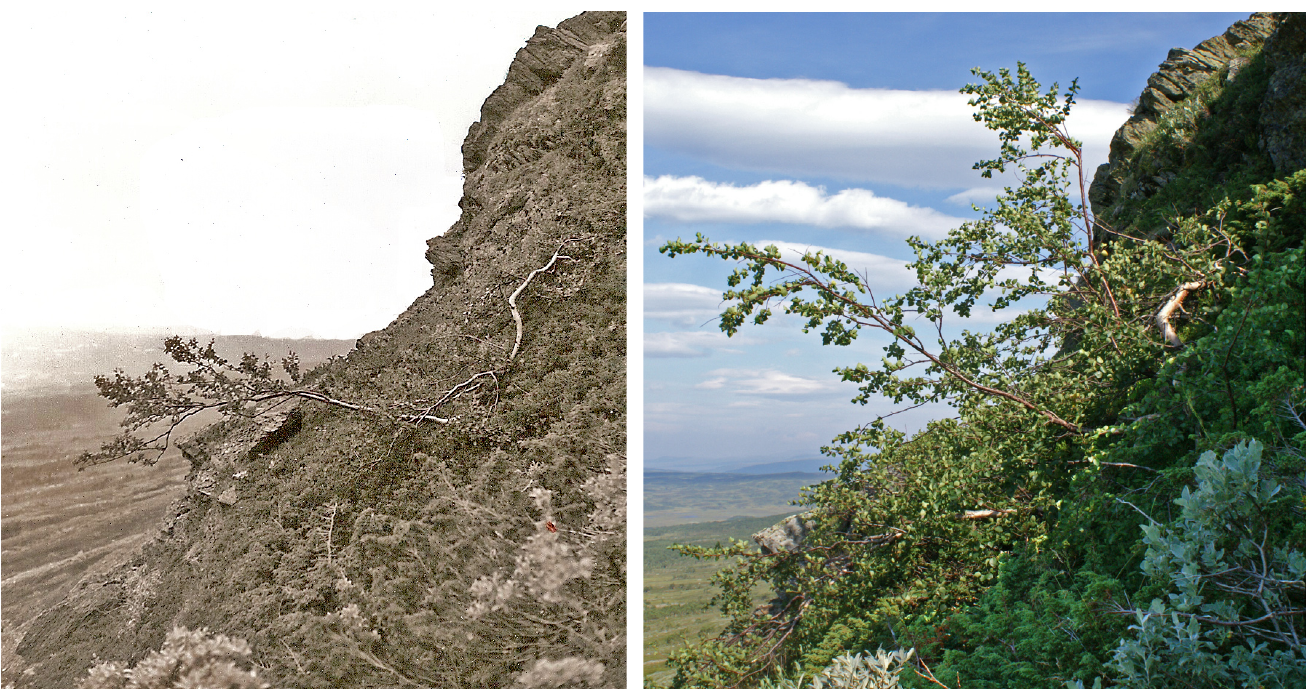
Figure 18. Left. Birches which have emerged above the treeline position in 1915. By the mid-1970s they had reached a size when they were readily broken by the weight of the snow pack. Right. In recent decades, they have rapidly retained their tree size as new stems have developed vegetatively from the bases of the downed trunks. Mt. Blåhammarkläppen 945 m a.s.l. 10 August